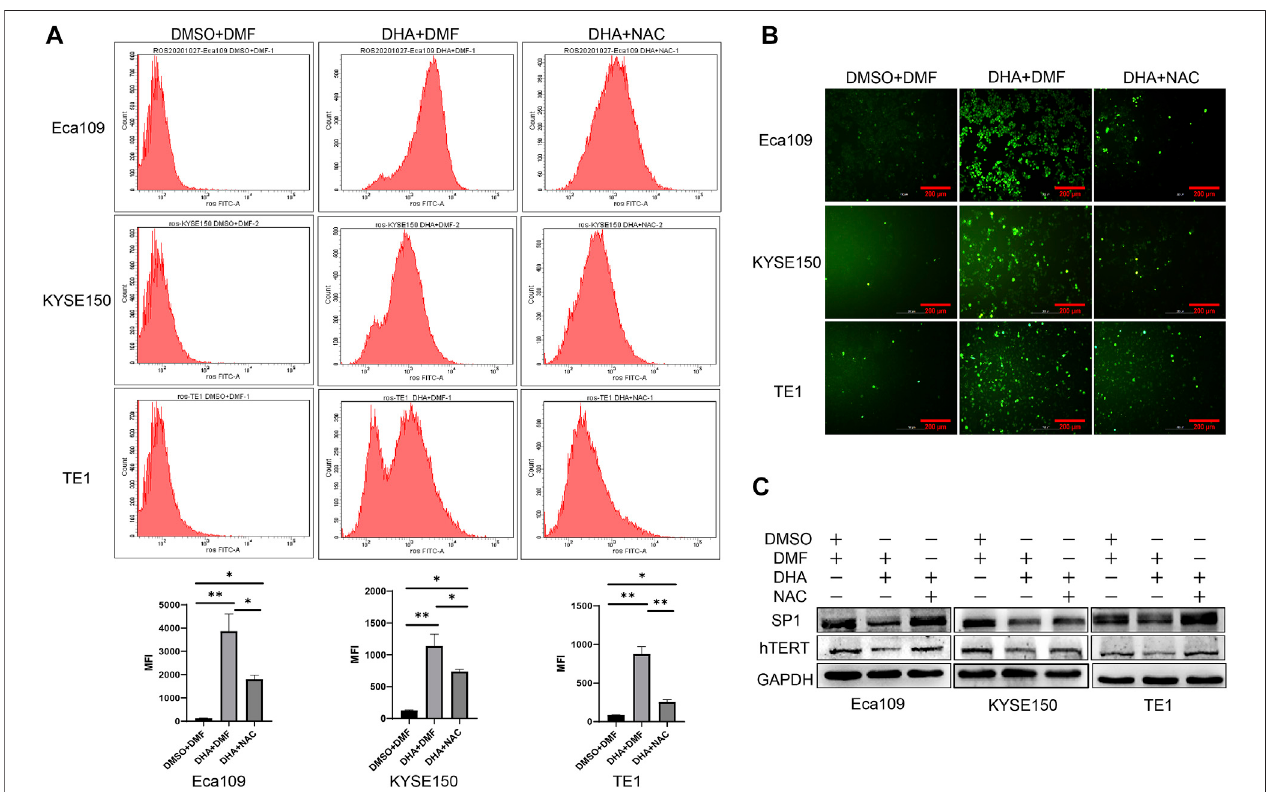
FIGURE 5| DHAinducesintracellularROSgenerationinEca109,KYSE150,andTE1cellsaftertreatedwithDHA. (A) Themean fl uorescenceintensity(MFI)ofcellstreated with or without DHA or NAC and the statistical charts. (B) Images from a fl uorescence microscope after cells treated with or without DHA or NAC followed by DCFH-DA co- incubation. (C) The expression of SP1 and hTERT protein in cells treated with or without DHA or NAC. (* indicate p < 0.05 and ** indicate p < 0.01 compared with control).